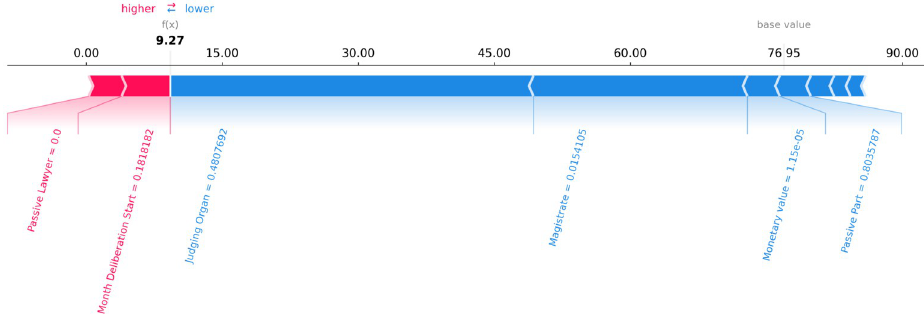
Fig 7. The contribution of each feature to the forecast of each row 2 of a random legal